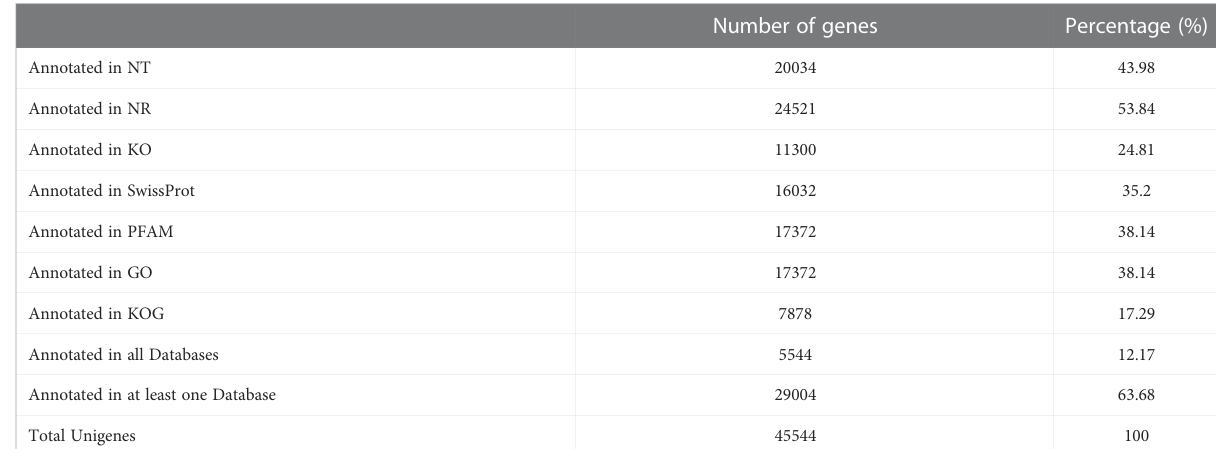
TABLE 4 Statistics of